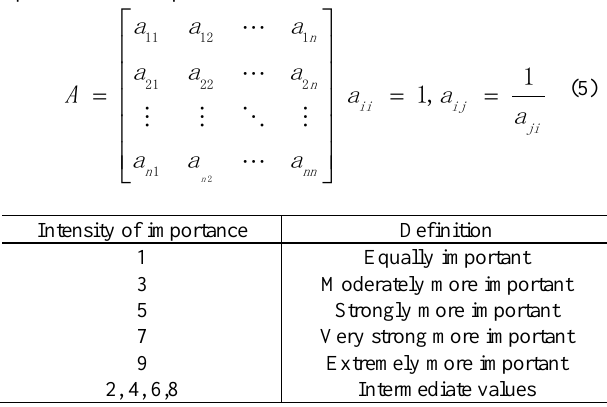
Table 1 Nine-point intensity of importance